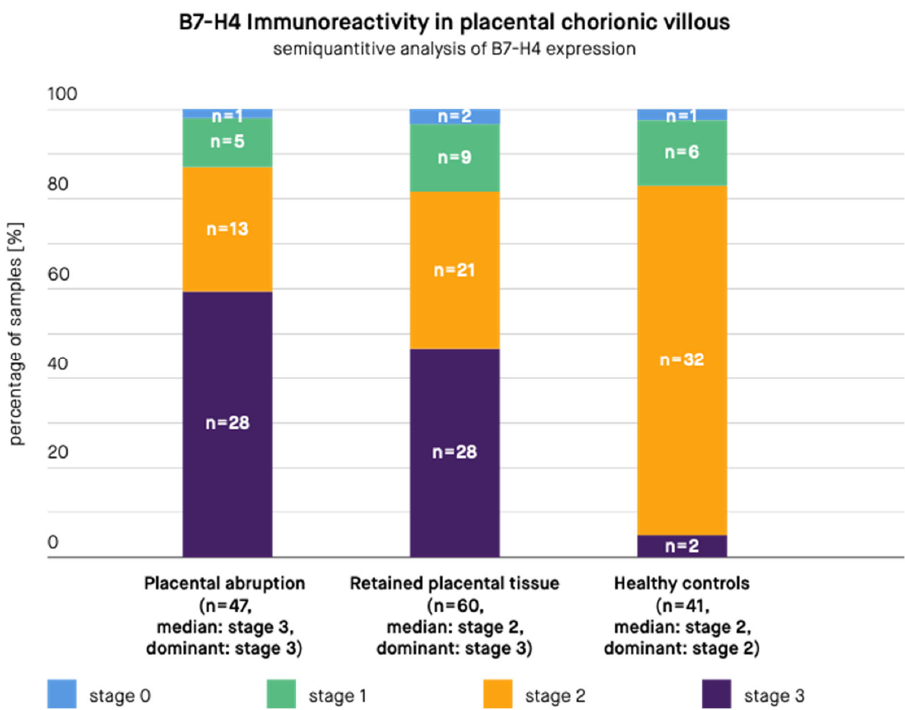
Figure 3. B7 ‐ H4 immunoreactivity in the placental chorionic villus in samples from patients with placental abruption, retained placental tissue, and healthy controls. n—Number of samples.